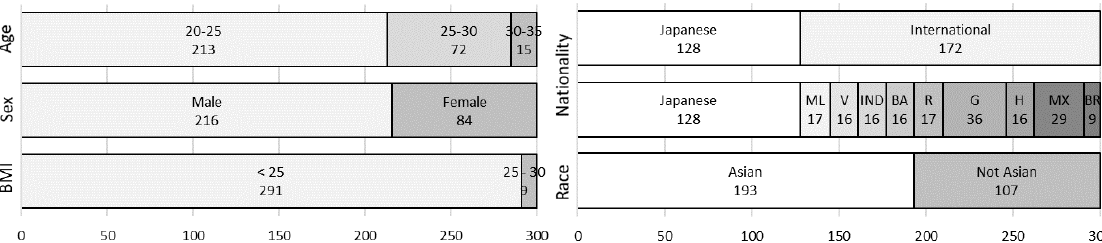
Figure 3. Population sample—Number of votes: Distribution relative to age, sex, nationality, race and